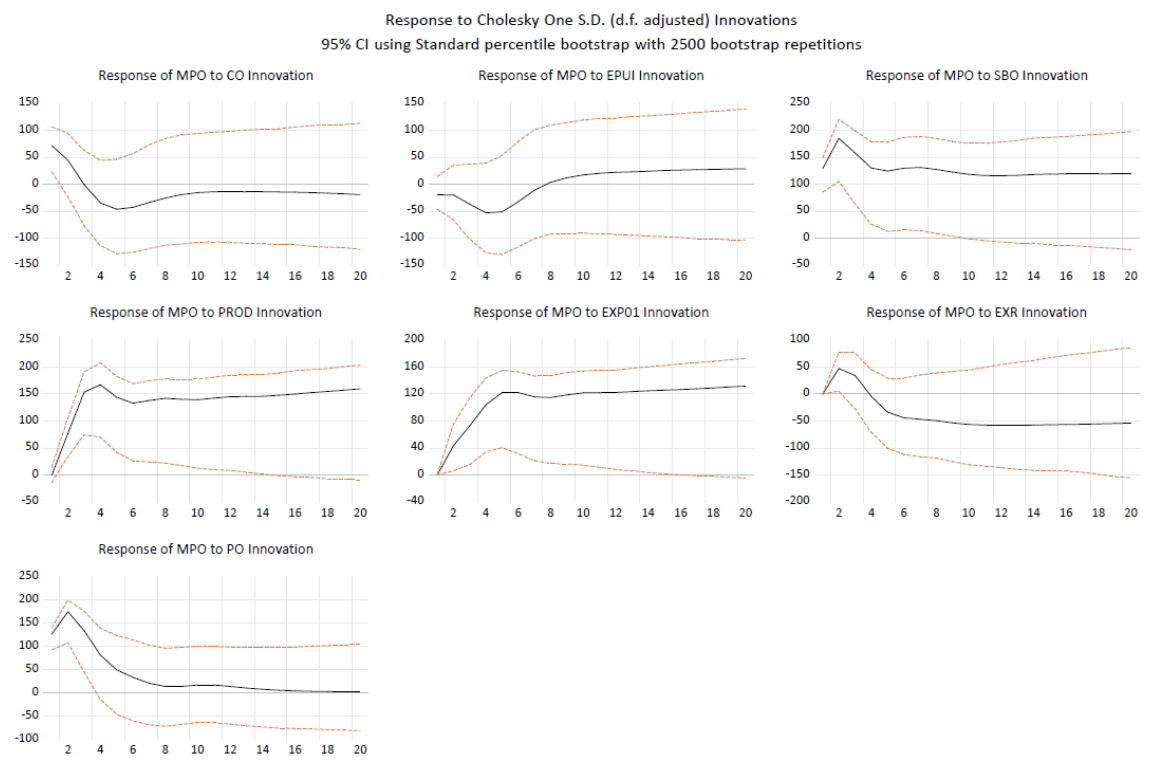
Figure 8. Impulse response after replacing IDVT with EPUI.